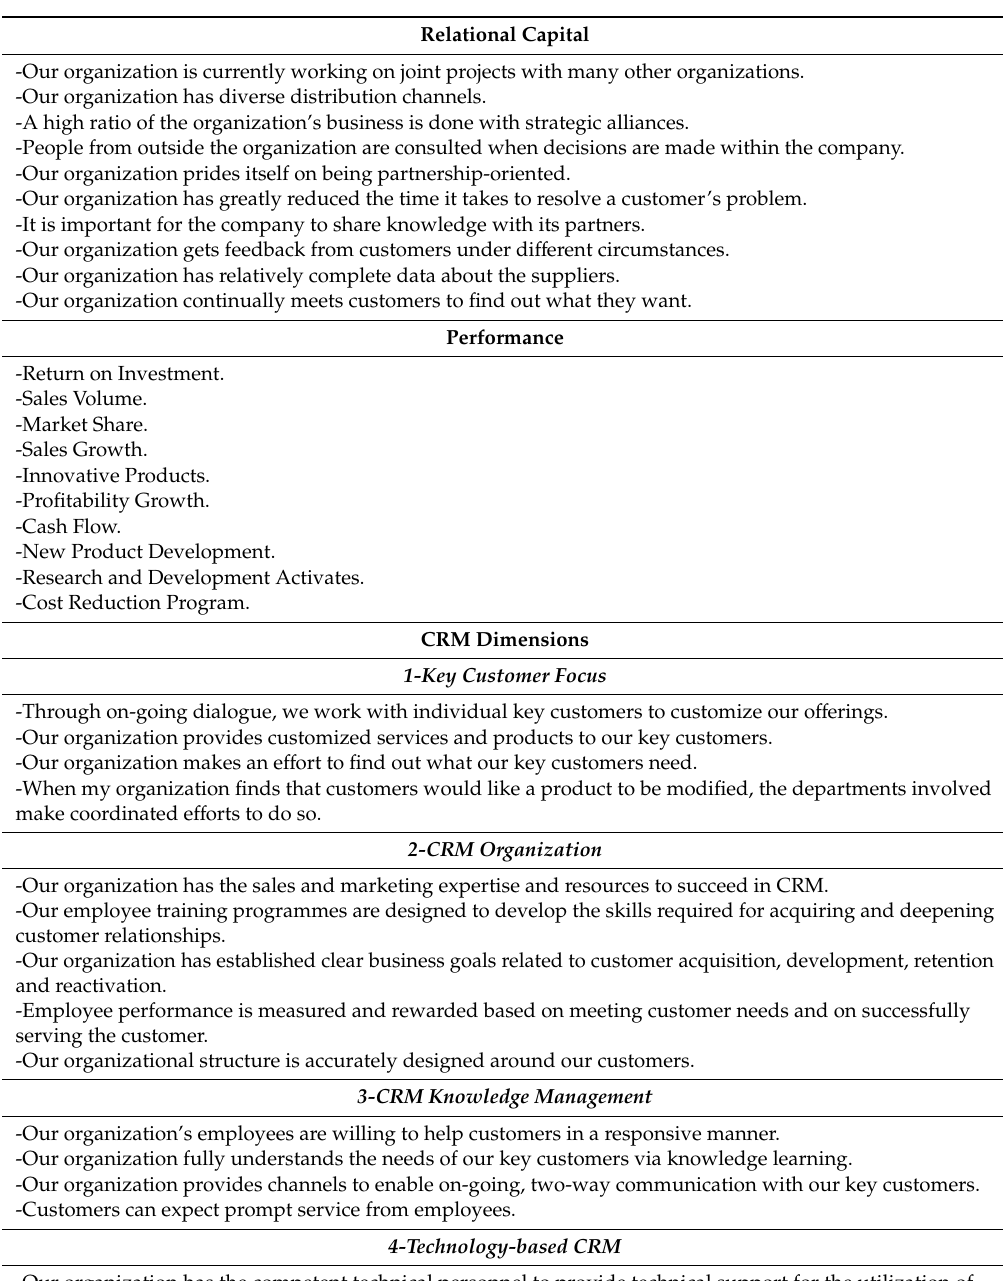
Table A1. Relational